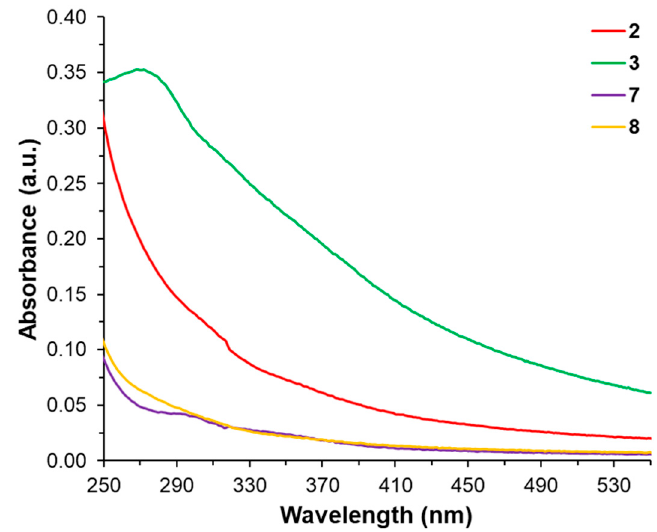
Figure 5. UV-Vis spectra of 2 , 3 , 7 , and 8 in PBS / DMSO mixtures. Content of DMSO is 1 vol % for all samples. [ruthenacarborane] = 20 µ M. Spectra are corrected via subtraction of the blank (PBS + 1 vol % DMSO).